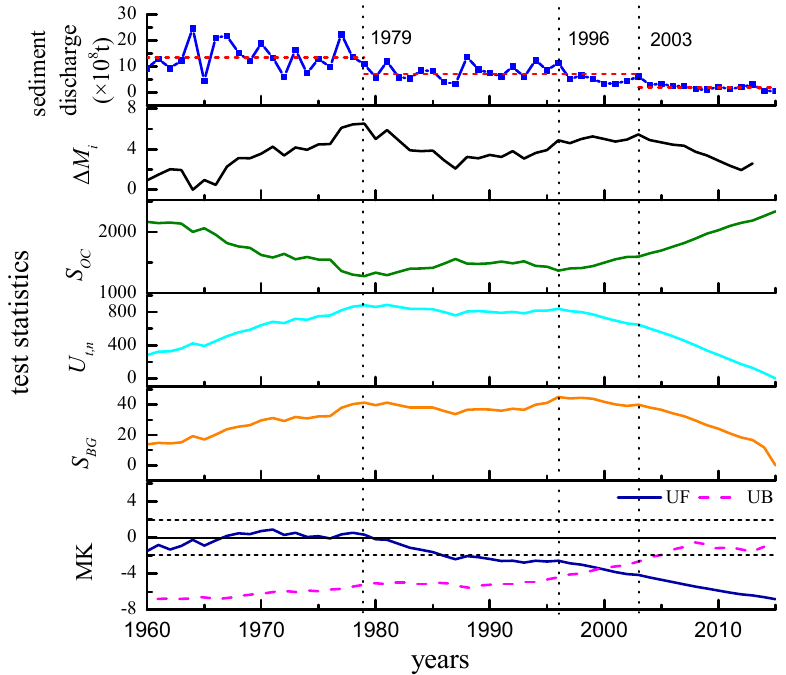
Figure 9. Detecting results of sediment discharge at Tongguan station.